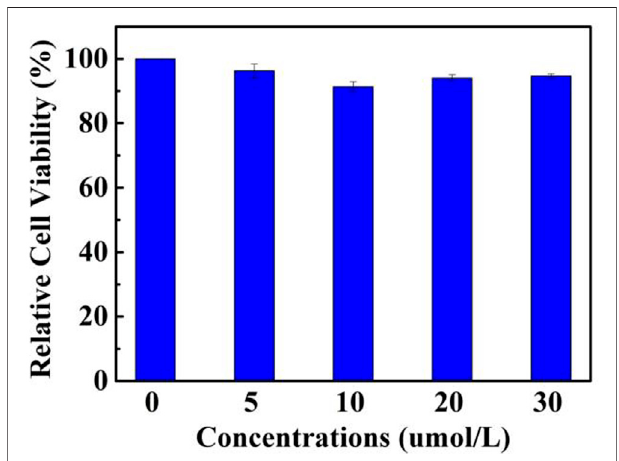
FIGURE 3 | The MTT assay of rhodanine derivative 1 for measuring cell viability.